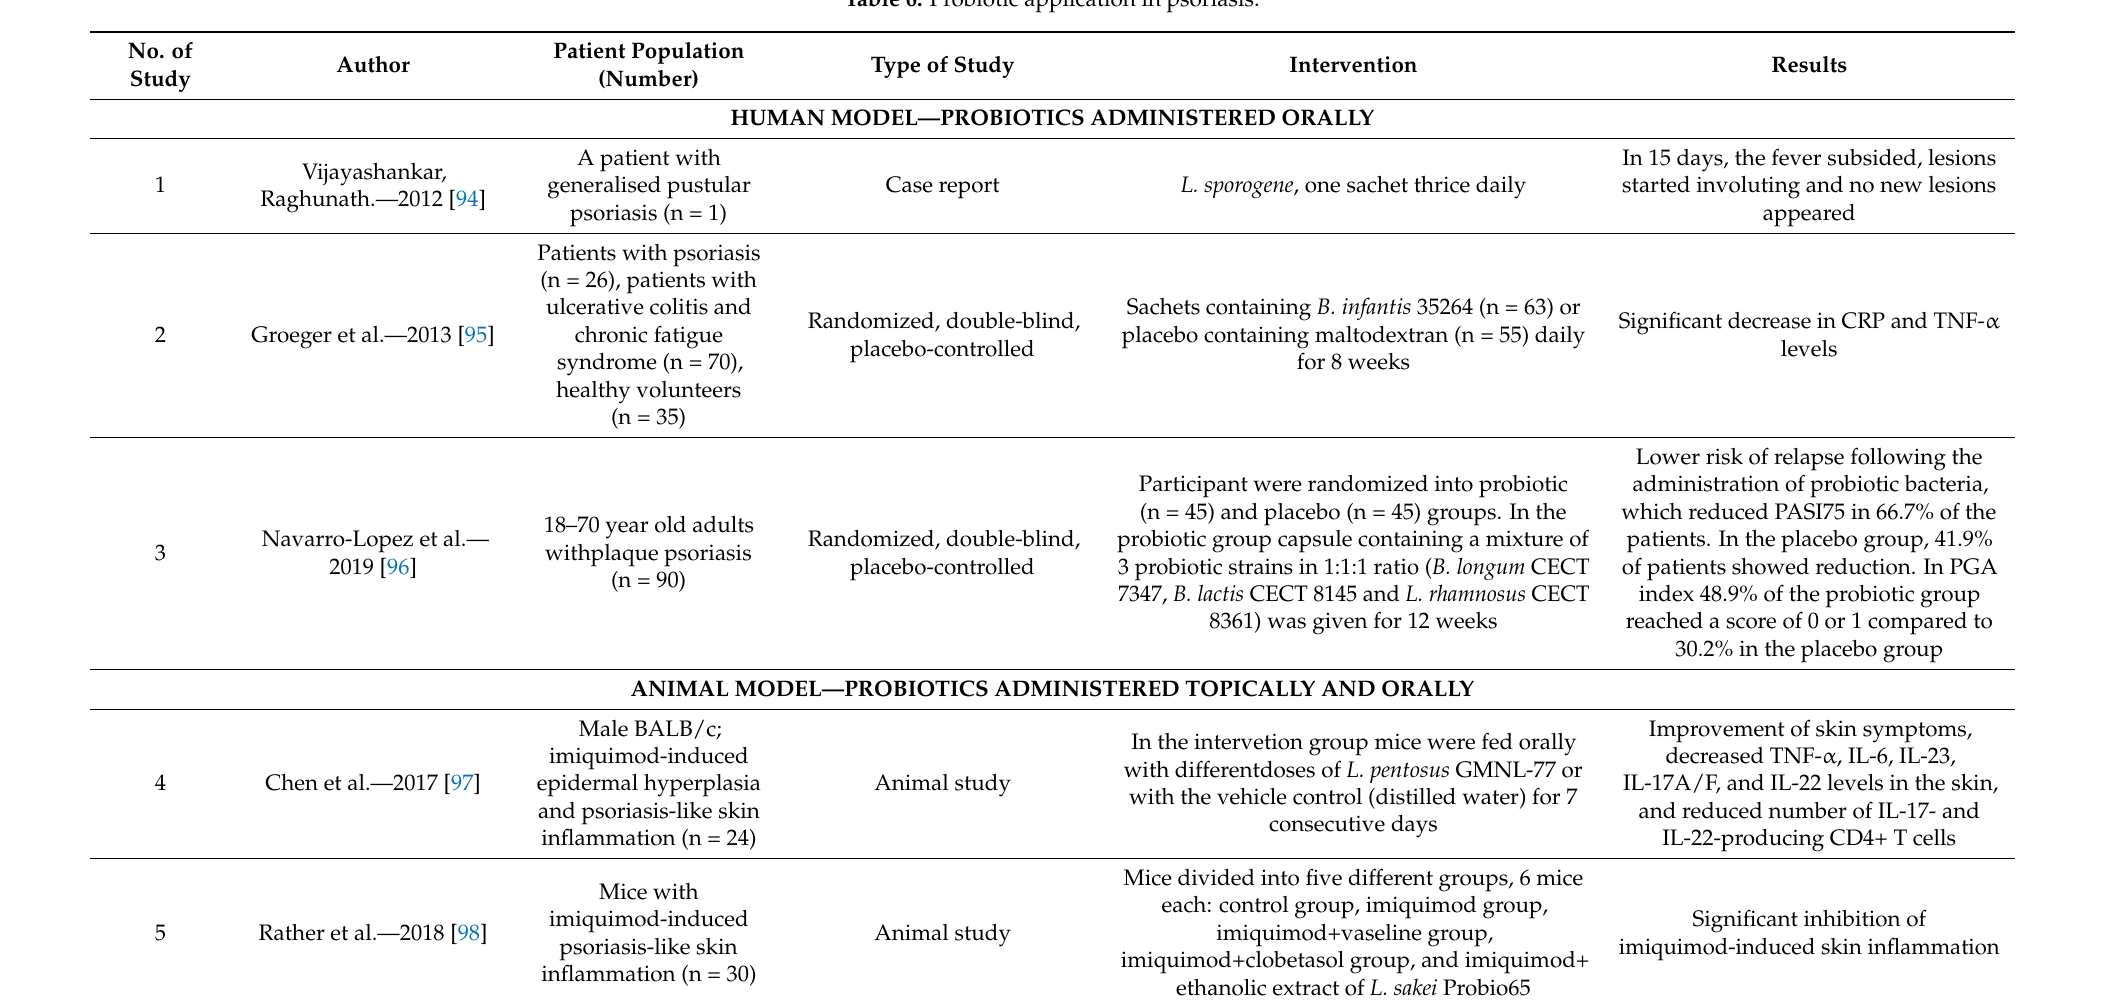
Table 6. Probiotic application in